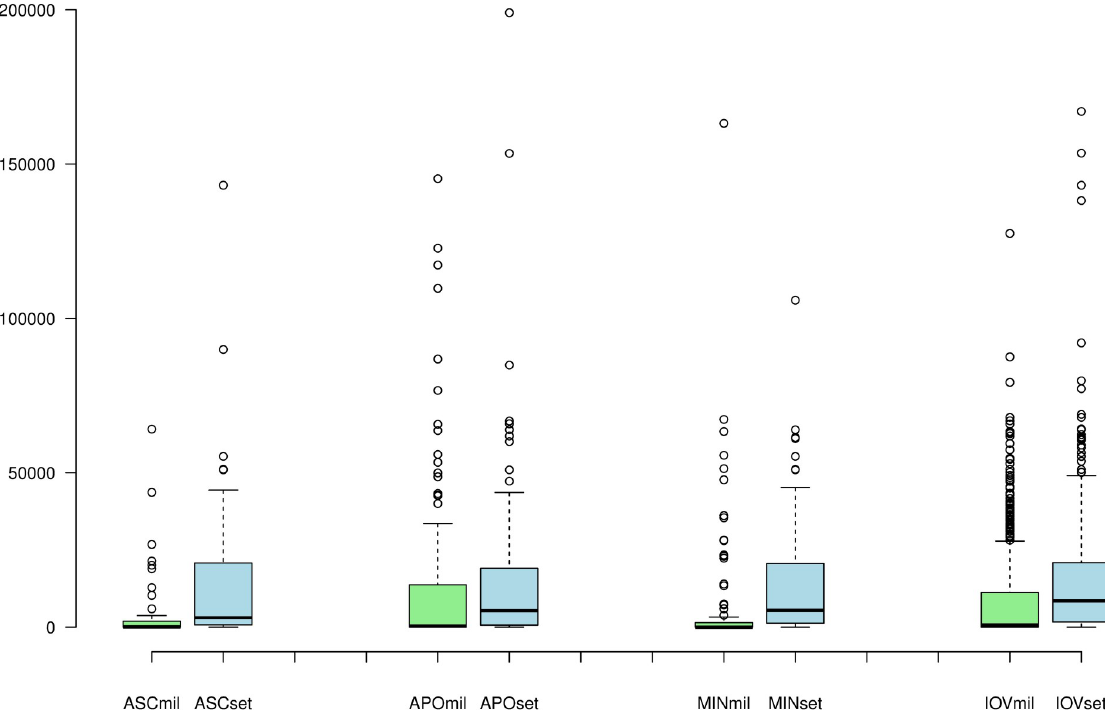
Fig 6. A box plot of distances measured on the transportation network (in meters) for all provinces of interest from unique cult locations to military proxies and Roman settlements. X axis shows labels for measurements with respect to individual cults. ASC (Asclepius), APO (Apollo), MIN (Minerva), IOV (Jupiter); mil (distances to the nearest military proxy), set (distances to the nearest settlement). Y axis shows the length of the distance reached in meters. Box plot: center lines show the medians; box limits indicate the 25th and 75th percentiles; whiskers extend 1.5 times the interquartile range from the 25th and 75th percentiles, outliers are represented by dots, their increased amount is caused by non-normal distribution of the data. Sources: Dataset of the variables [49].